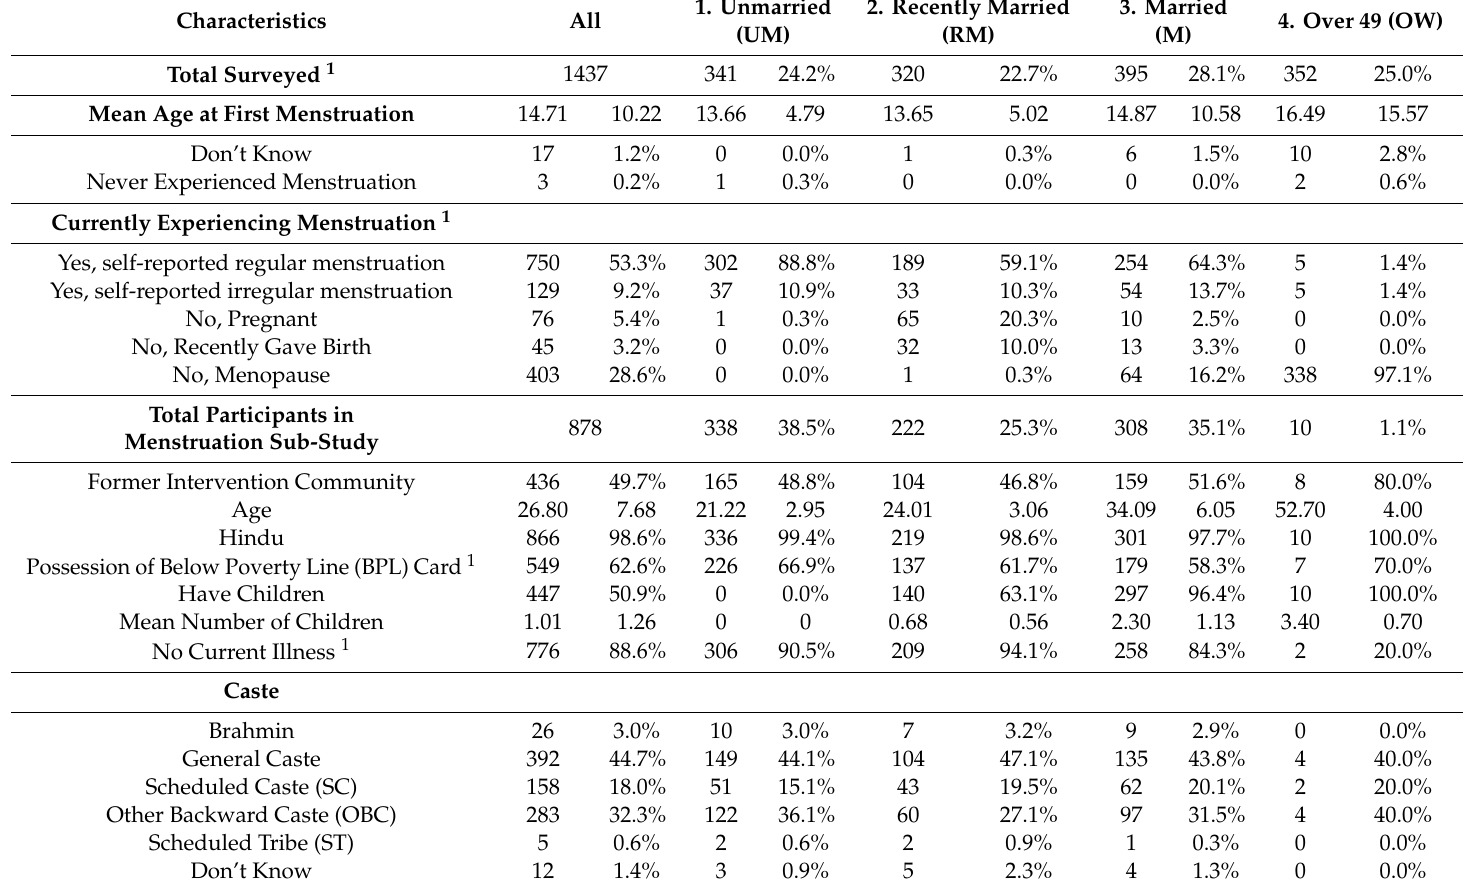
Table 1. Demographic characteristics of participants, overall and by life stage, in rural Orissa,